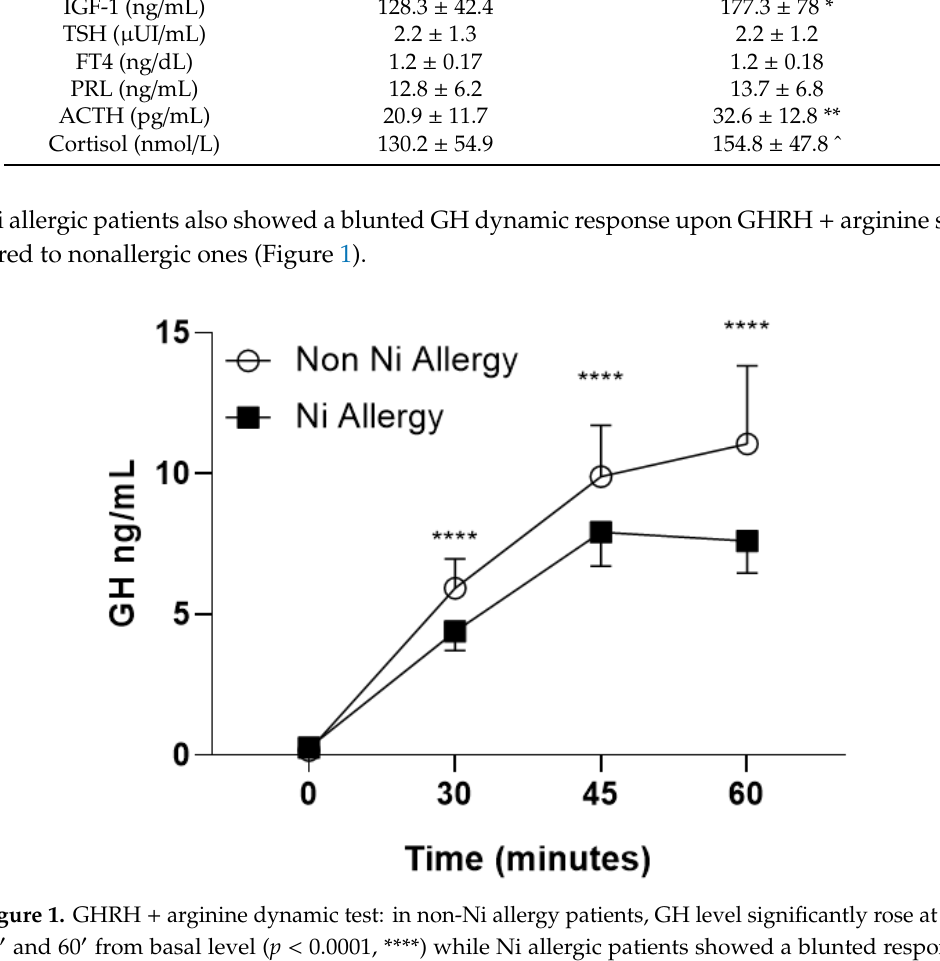
Figure 1. GHRH + arginine dynamic test: in non-Ni allergy patients, GH level significantly rose at 30 ′ , 45 ′ and 60 ′ from basal level ( p < 0.0001, ****) while Ni allergic patients showed a blunted response, with nonsignificant increase in GH level during the test. Abbreviation: Ni, Nickel; GH, Growth Hormone; GHRH, growth hormone releasing hormone. **** p < 0.0001 .